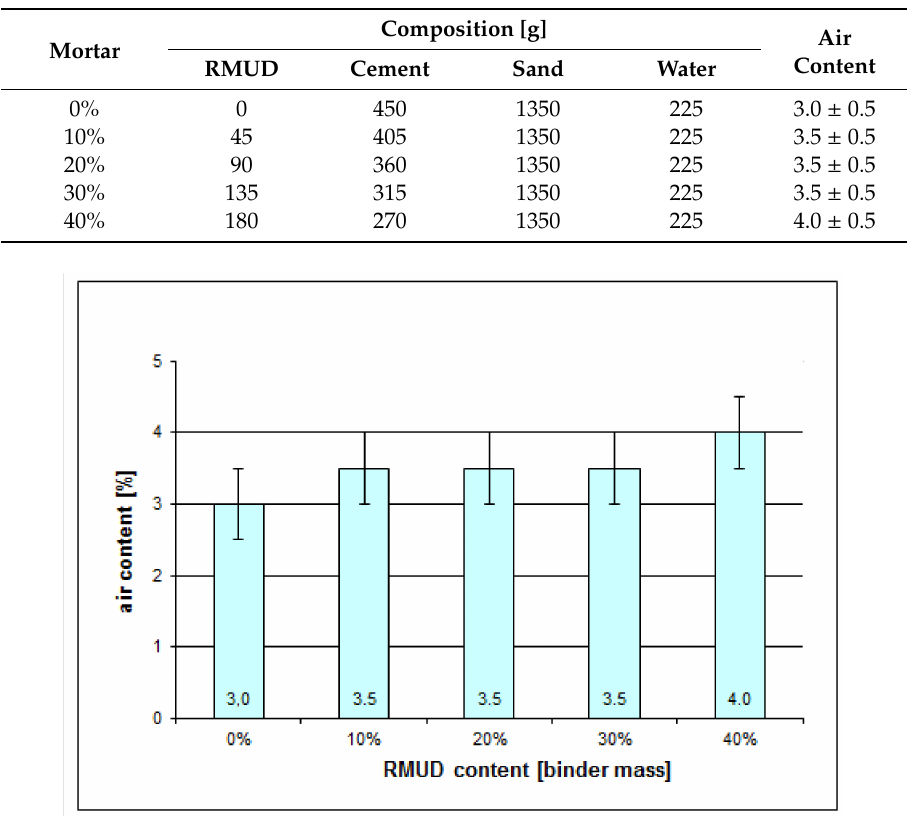
Figure A1. Influence of addition RMUD on air content in